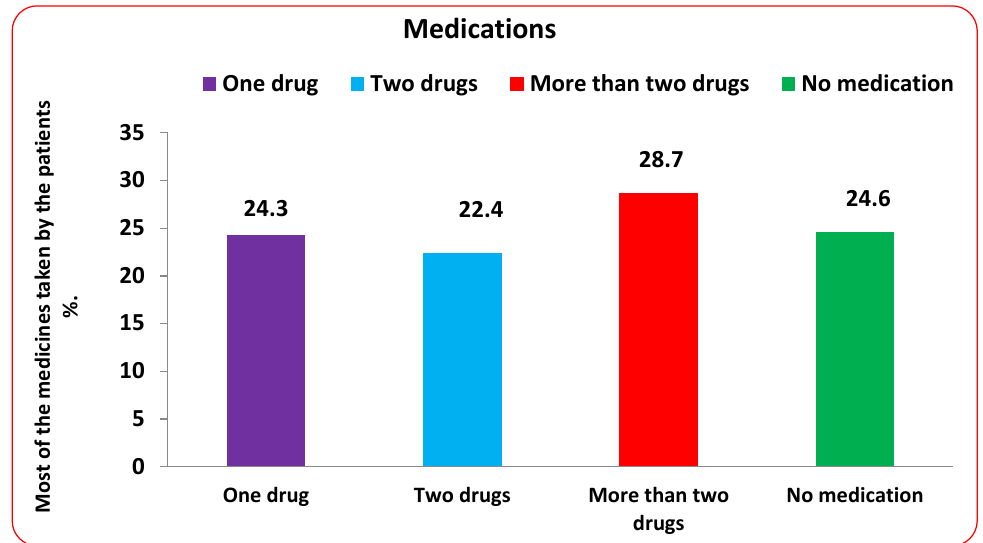
Figure 2. The mono, dual, and multiple therapies of the studied patients.